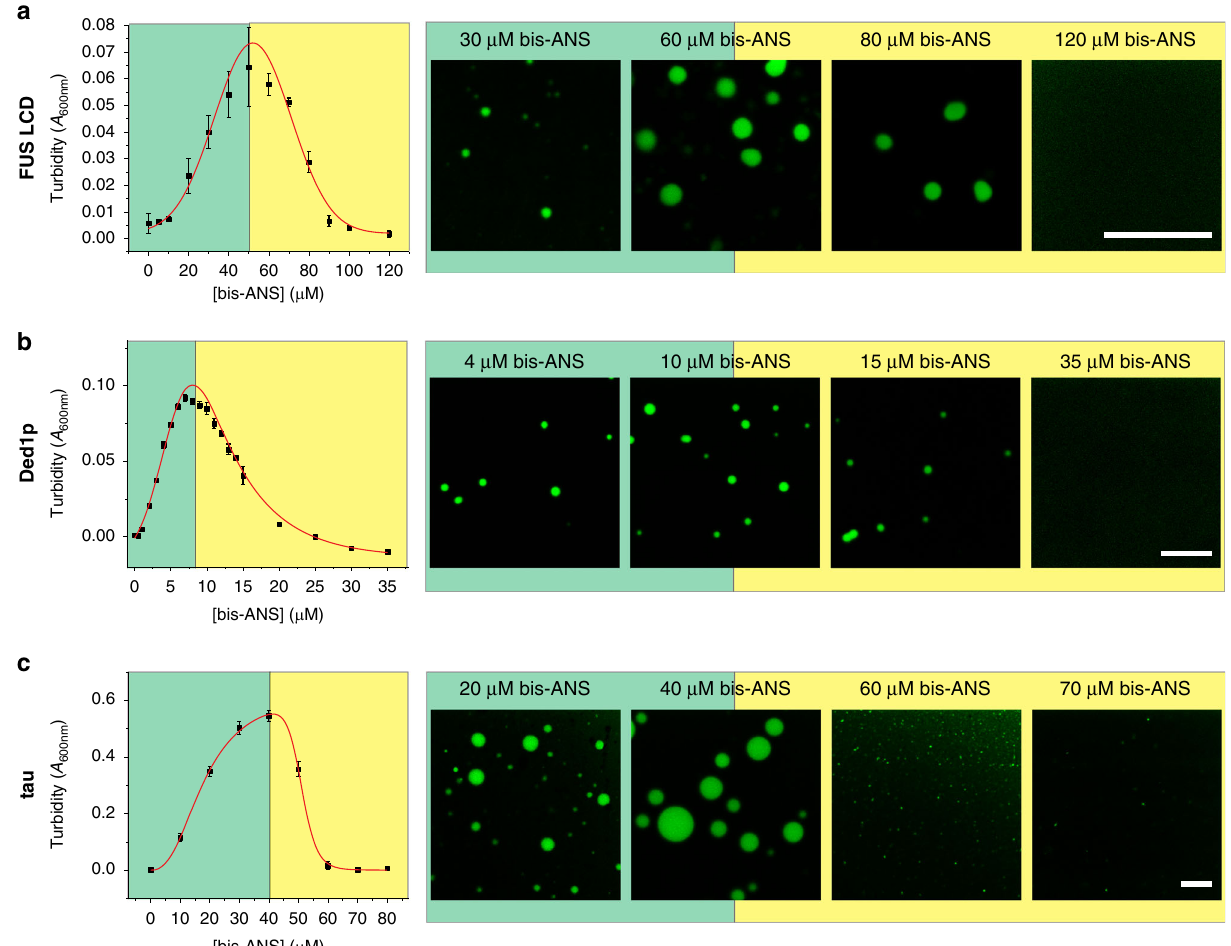
Fig. 6 Bis-ANS modulates phase behavior of FUS LCD, Ded1p, and tau. a , b Turbidity curves and representative fl uorescence microscopy images of a FUS LCD (20 μ M), b full-length Ded1p (1 μ M) and c full-length tau (10 μ M) in the presence of varying bis-ANS concentrations. Scale bars: 10 μ m. All data are presented as mean values ± standard deviation ( n = 3 technical